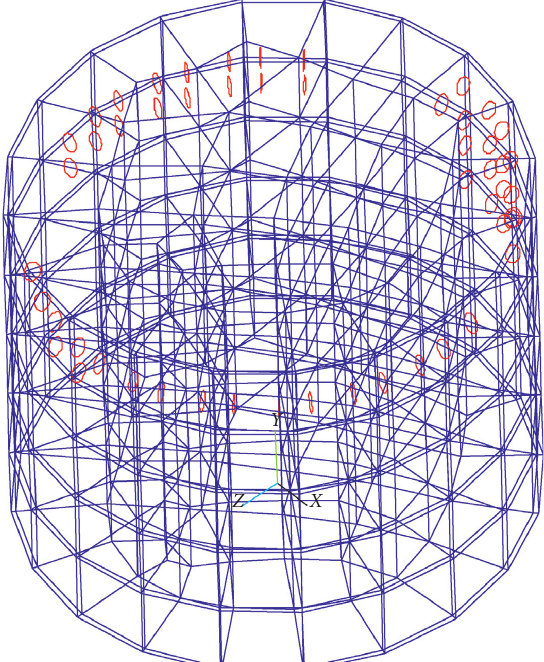
Figure 22: Spherical hinge cracking diagram 1.